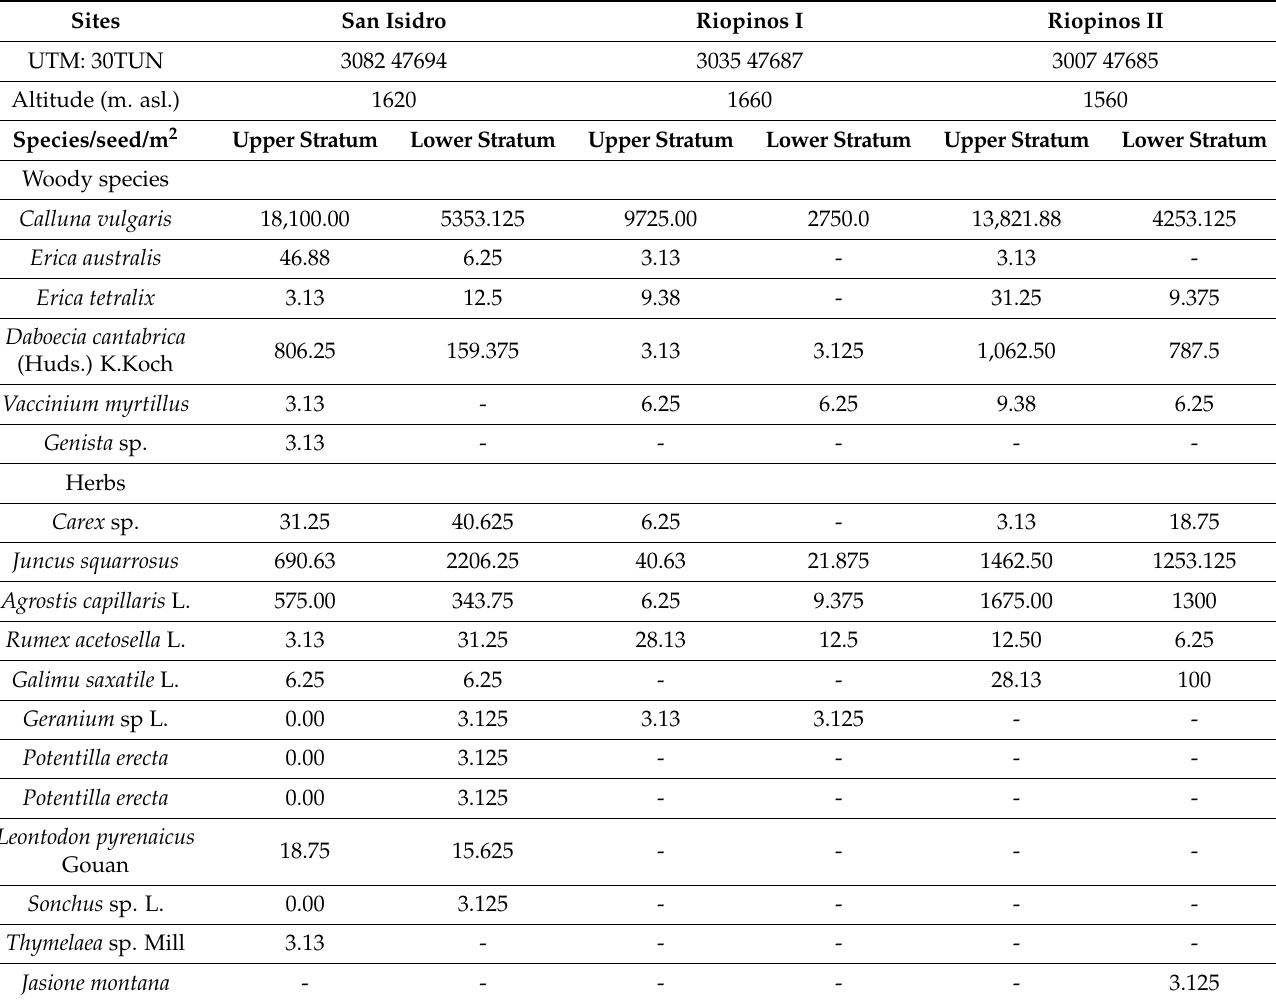
Table 3. Overall description of the soil seed bank after burning in 2005 in the three selected heathlands in the Cantabrian Mountain range